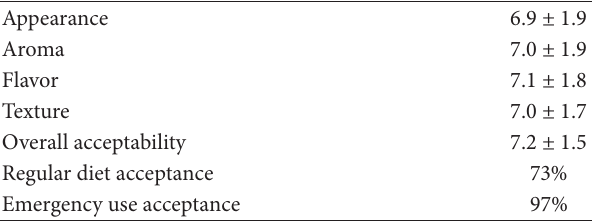
Table 8: Weibull sensory data for dehydrated taro slices stored at 45 ∘ C in PE bags.